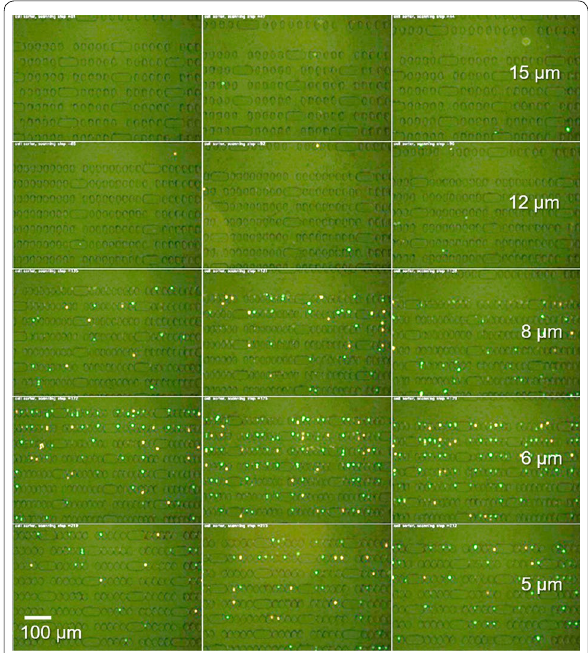
Fig. 2 Partial scanned images of the filtration zone for T and B